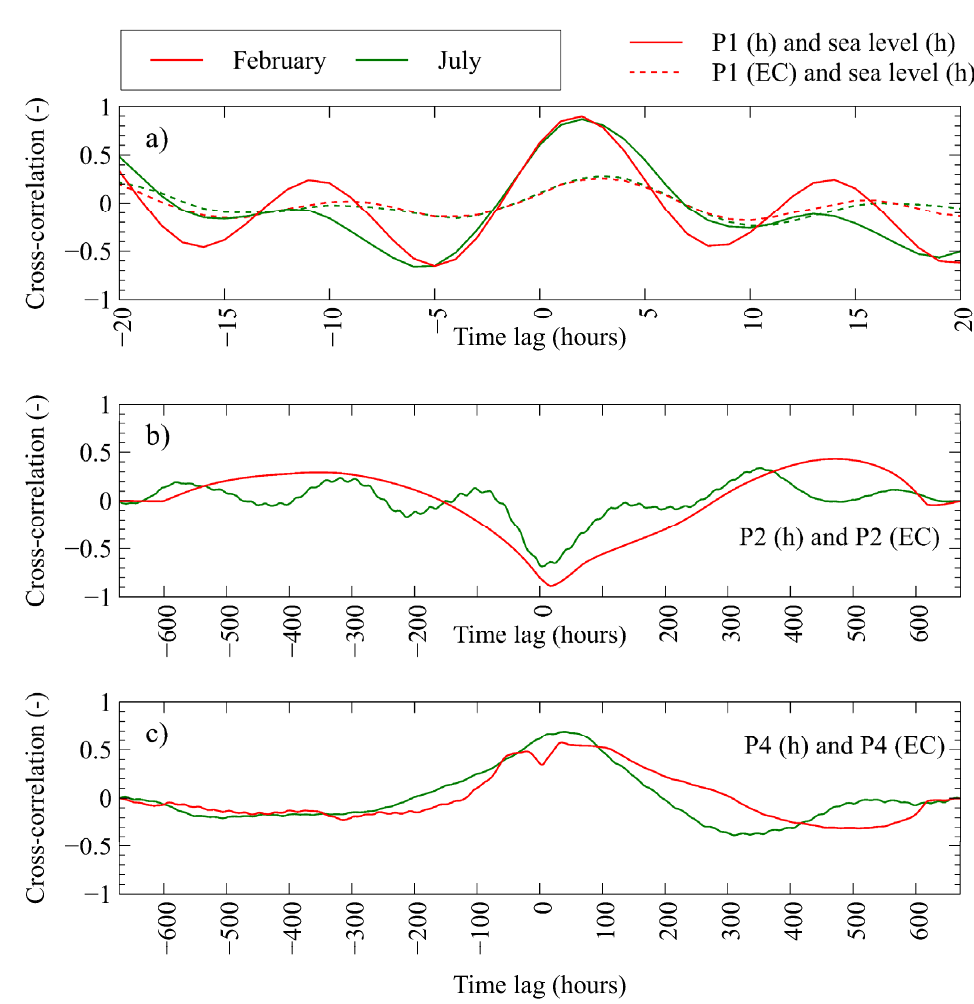
Figure 7. Cross-correlation functions determined for February and July 2019: ( a ) Sea level—h and sea level—EC cross-correlation functions for P1; ( b ) h and EC cross-correlation functions for P2 and ( c ) h and EC cross-correlation functions for